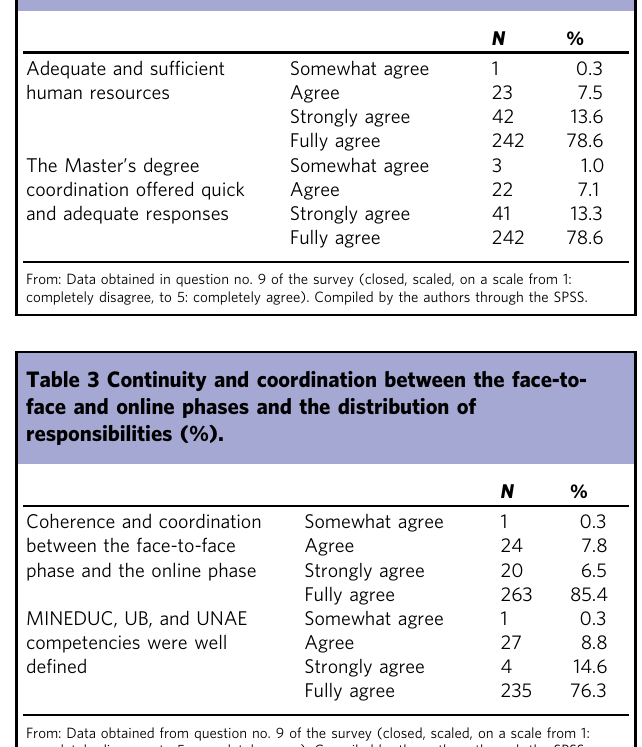
From: Data obtained from question no. 9 of the survey (closed, scaled, on a scale from 1: completely disagree, to 5: completely agree). Compiled by the authors through the SPSS.